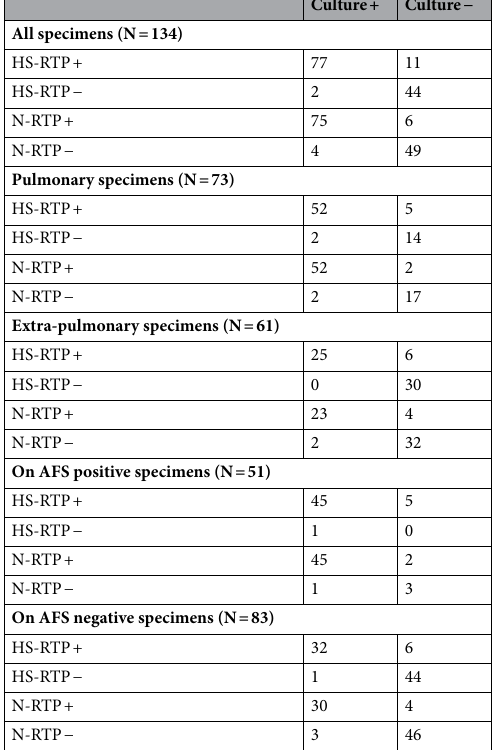
Table 3. Performance comparisons between the HS-RTP, the N-RTP, and culture under different conditions, including overall specimens, pulmonary specimens (sputum, bronchoalveolar lavage (BAL) and bronchial washing (BW)), extrapulmonary specimens, AFS-positive specimens and AFS-negative specimens. AFS: acid fast stain; + : positive; − : negative. N: sample